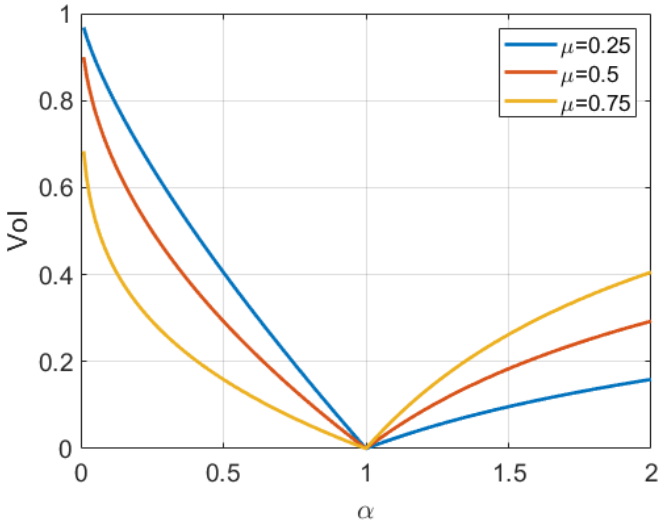
Figure 1. The normalized value of information for different values of µ and different initial